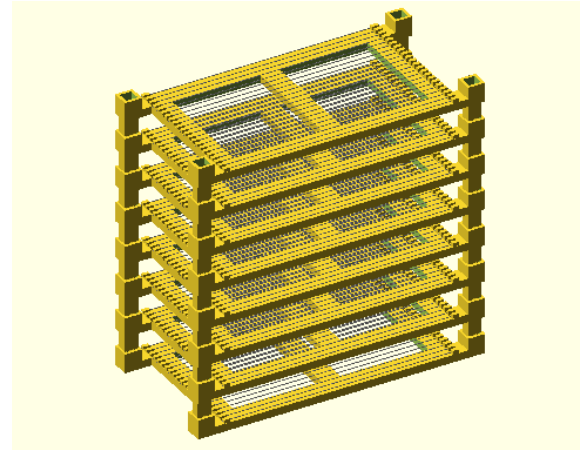
Figure 1. A rendering of the slide dryer in OpenSCAD.